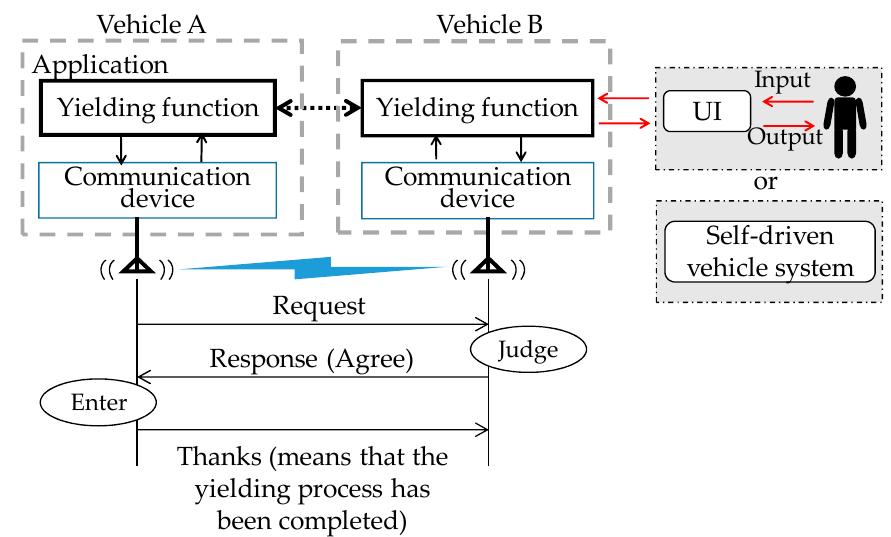
Figure 1. Overview of the yielding process.